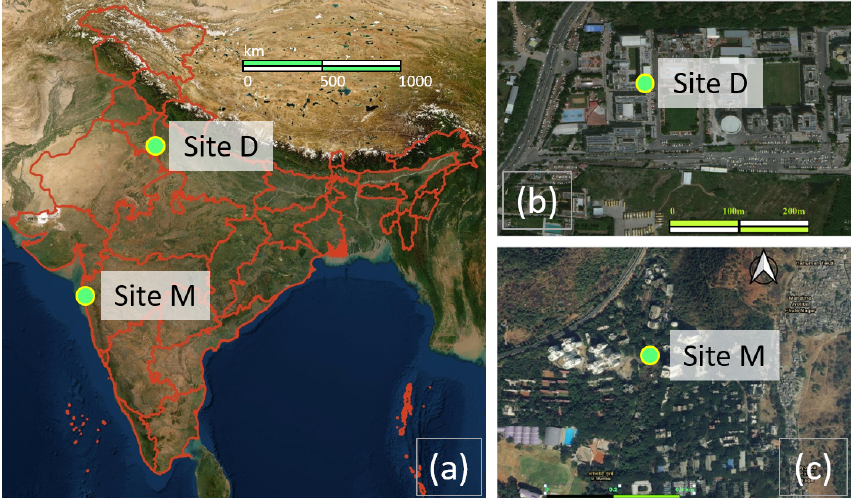
Figure 1. A map showing the locations of the deployment sites. Panels (b) and (c) show a local-scale map of the vicinity of the deployment sites – namely site D at MRIIRS, Delhi NCR (b) , and site M at MPCB, Mumbai (c) , with the sites themselves pointed out using bright green dots. Panel (a) shows the location of the sites on a map of India. Credit for map sources: (a) is taken from the NASA Earth Observatory with the outlines of the Indian states in red taken from QGIS 3.4 Madeira; (b) and (c) are obtained from © Google Maps. The green markers for the sites in all figures were added separately.